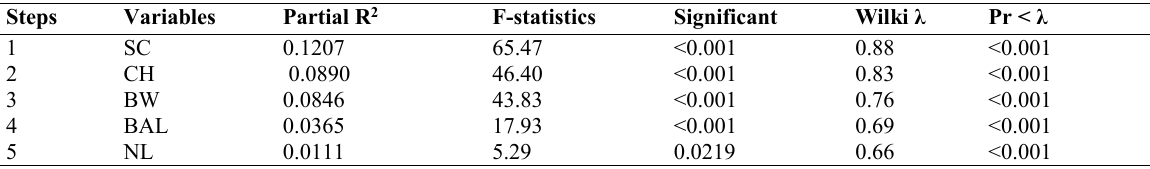
Table 3. Summary of discriminate stepwise selection among the two districts chickens.